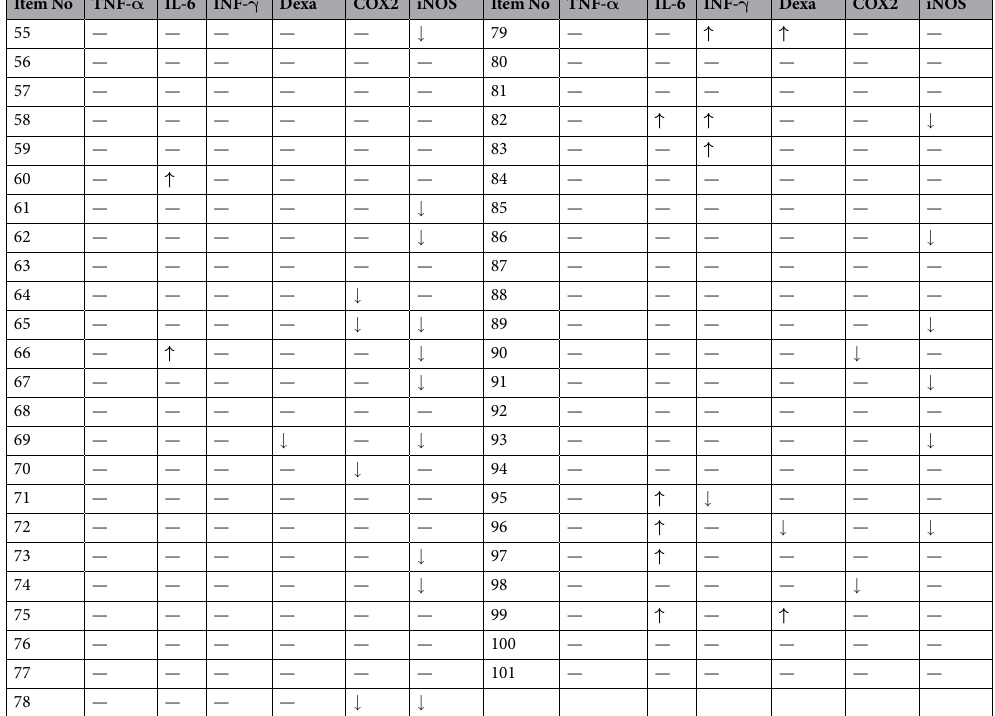
Table 2. Effect of Bu Yi Yao enzyme activity for proinflammatory chemical synthesis or inflammatory cytokine or hormone signaling pathways. TNF- α : TNF α -NF κ B luciferase reporter; IL-6: IL-6-STAT3 luciferase reporter; INF- γ : INF γ -GAS luciferase reporter; Dexa: Dexamethasone-GRE luciferase reporter; COX2: COX2 enzyme activity; iNOS: iNOS enzyme activity. ↓ : inhibition ≥ 50%; ↑ : stimulation ≥ 3 folds; —: no impact w/o β -glucuronidase treatment at concentration ≤ 750 µ g/ml in the inflammatory cytokine or glucocorticoid signaling pathway and at concentration ≤ 4 mg/ml in COX2, iNOS enzyme activity